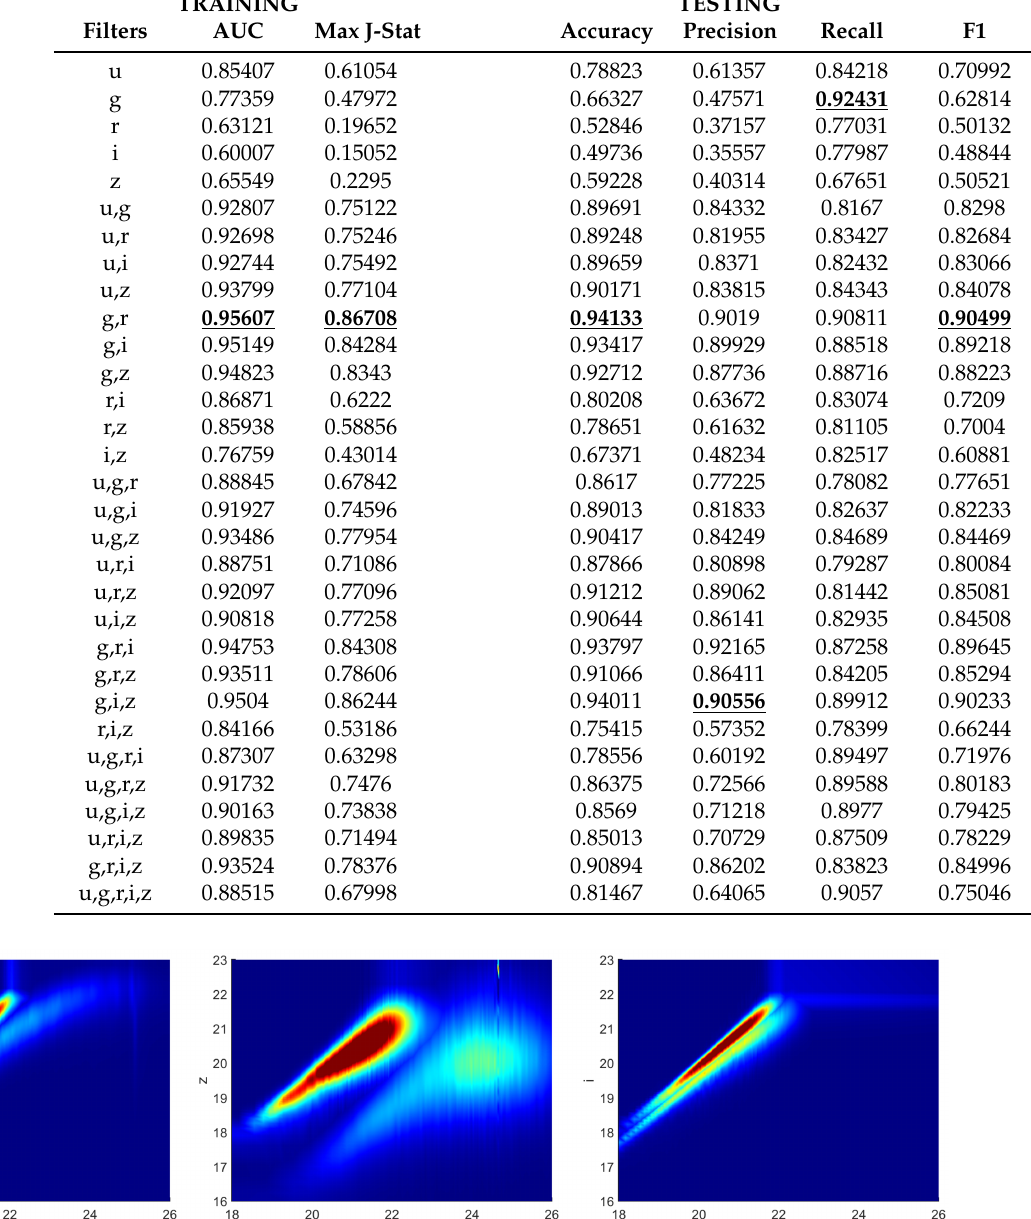
Table 6. Results for binary classification of quasars. Highest values for each column are written in bold font and underlined. For reference, AUC is the area under the ROC curve, and the four measures are defined as: accuracy = tp The underlined values in bold are the greatest value obtained per column.